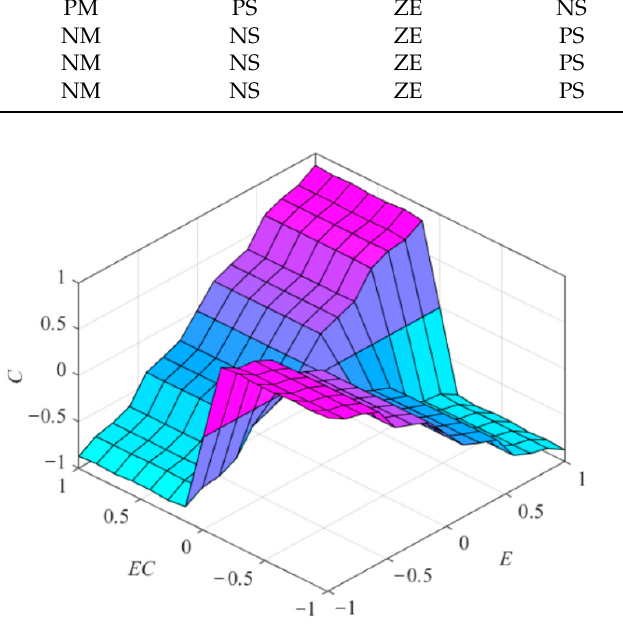
Figure 9. 3D output surface of fuzzy control rules.